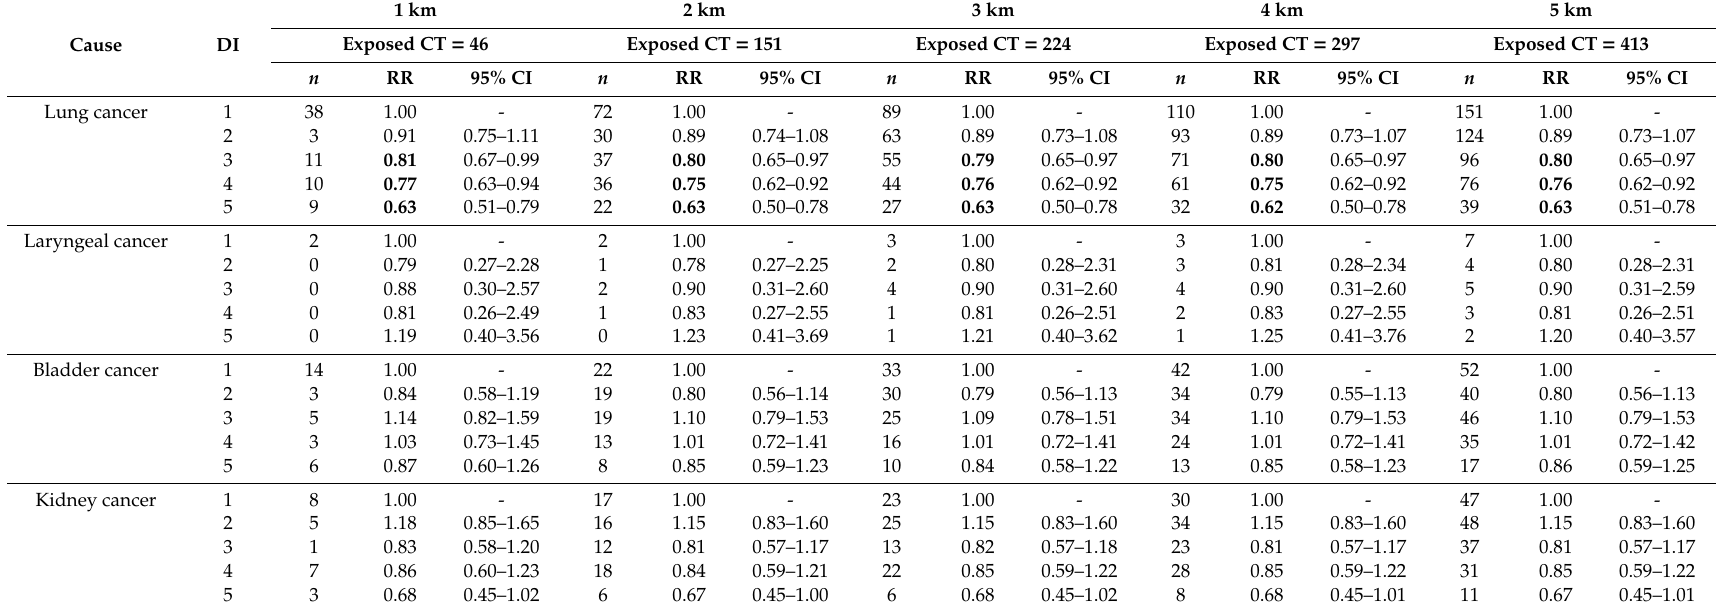
Table 2. RRs for deprivation index adjusted for distance of exposure for the female